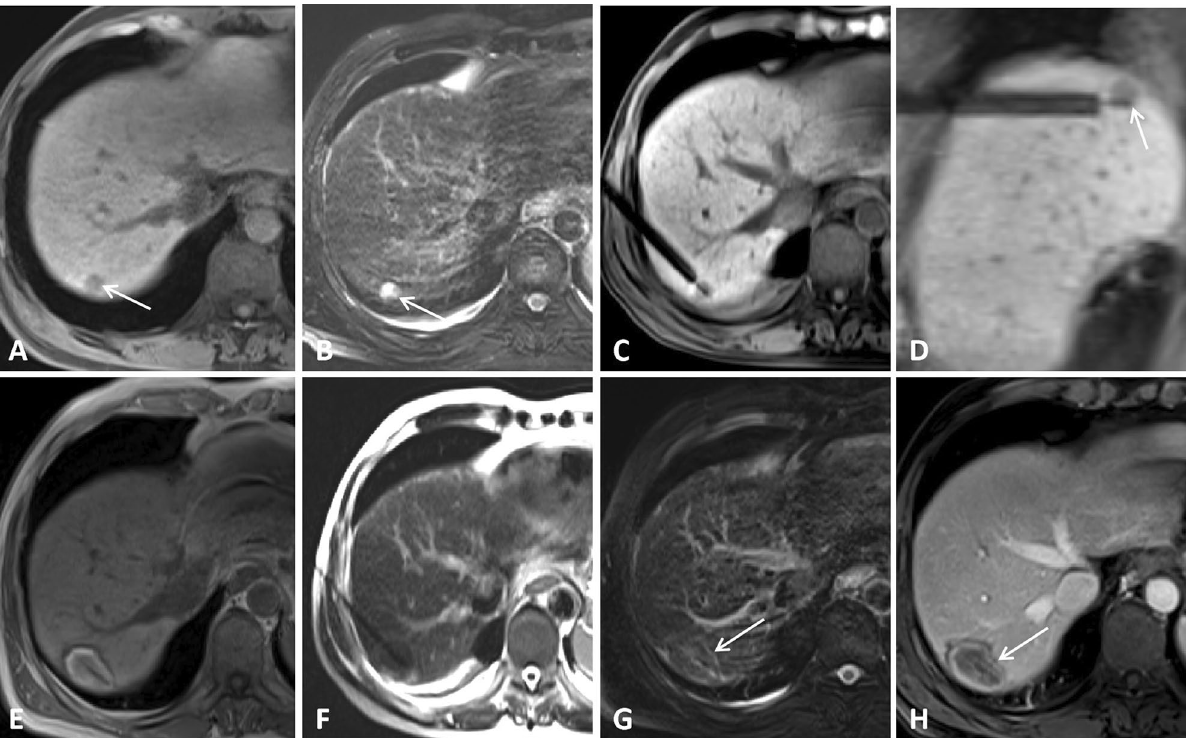
Figure 1. A 62-year-old man with gastric carcinoma and liver metastasis at segment 7. ( A , B ) Pretreatment MR showed a small lesion (diameter = 0.9 cm) on T1WI ( A ) and T2WI ( B ); ( C , D ) Lesion was punctured by a microwave applicator on cross section ( C ) and sagittal sections ( D ); ( E ) T1WI showed that the ablation focus was ellipsoidal with a high signal, and the central low-density area was the primary tumor; ( F , G ) T2WI showed that the high signal of the original tumor disappeared in the nonfat-suppression phase ( F ) and fat-suppression phases ( G ); ( H ) Enhanced MR showed that the focus was completely ablated at the 1-month evaluation (white